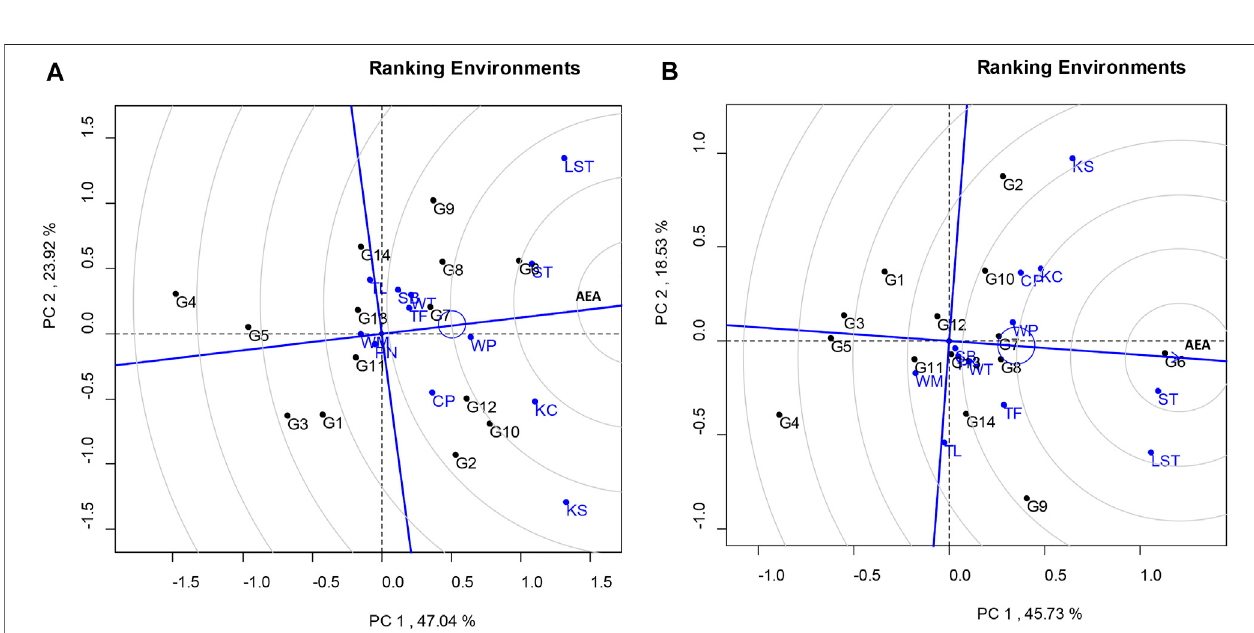
FIGURE 2 | GGE biplot based on genotype-focused scaling comparing tested genotypes with ideal genotypes. (A) Pod yield. (B) Seed yield.